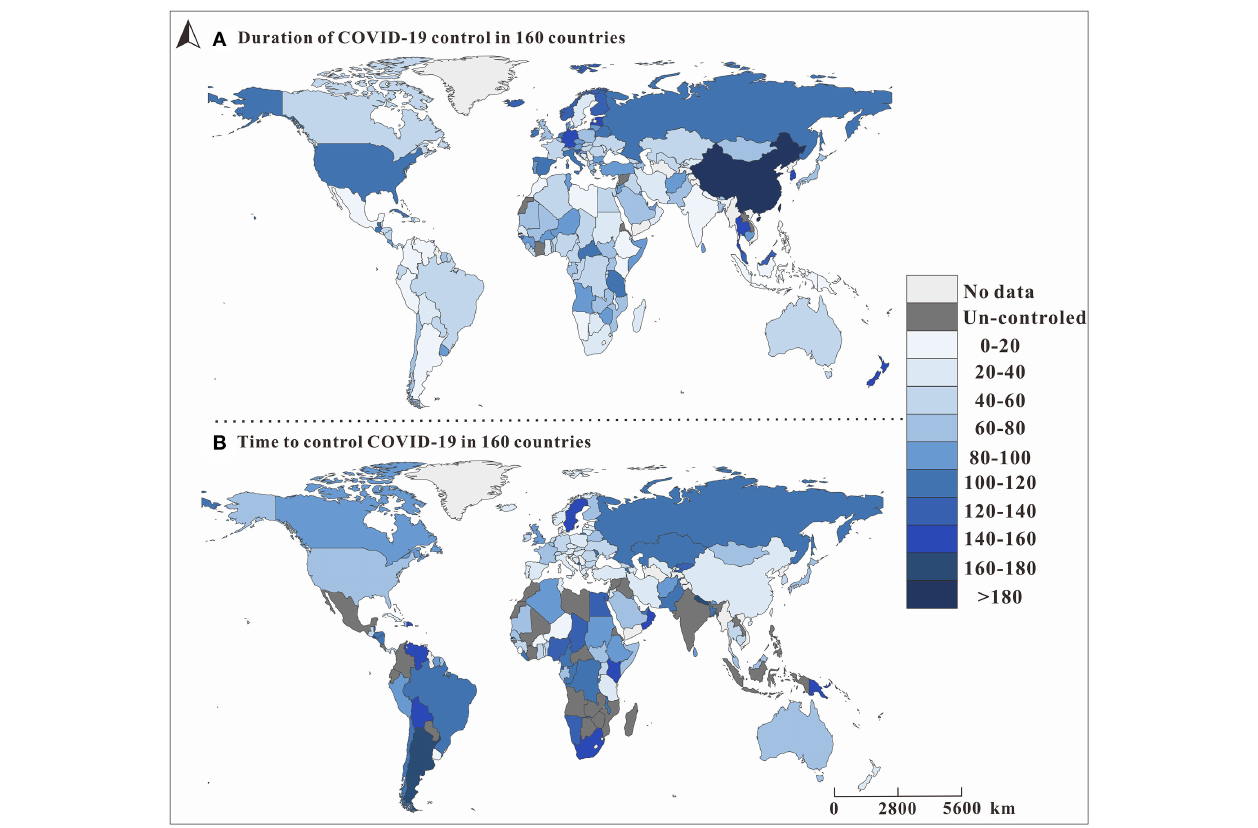
FIGURE 6 | The spatial distribution of I Tn and I Cj in 160 countries. I Tn is defined as the grade of time it will take to bring COVID-19 under control, and n represents the level of the time required to control the COVID-19 epidemic. I Cj is the grade of countries where COVID-19 has been brought under control ( R eff < 1) as of August, 22, 2020; j represents whether the country under study has the ability to control the COVID-19 epidemic. The map depicted in these figures were taken from Wikimedia Commons